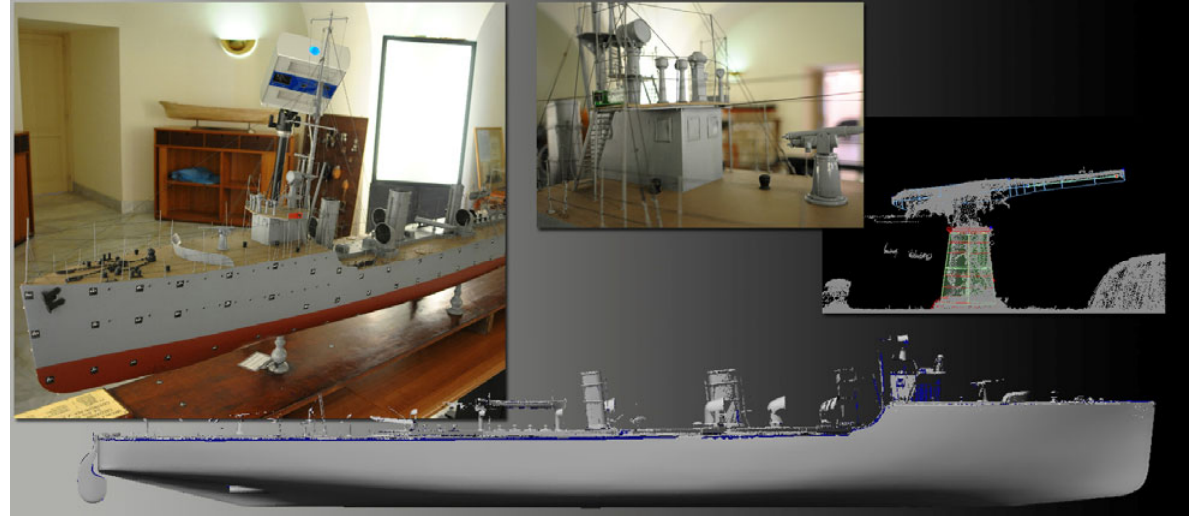
Figure 4: Hybrid survey for 3D modelling of the “Indomito” model of Maritime Museum - Parthenope University of